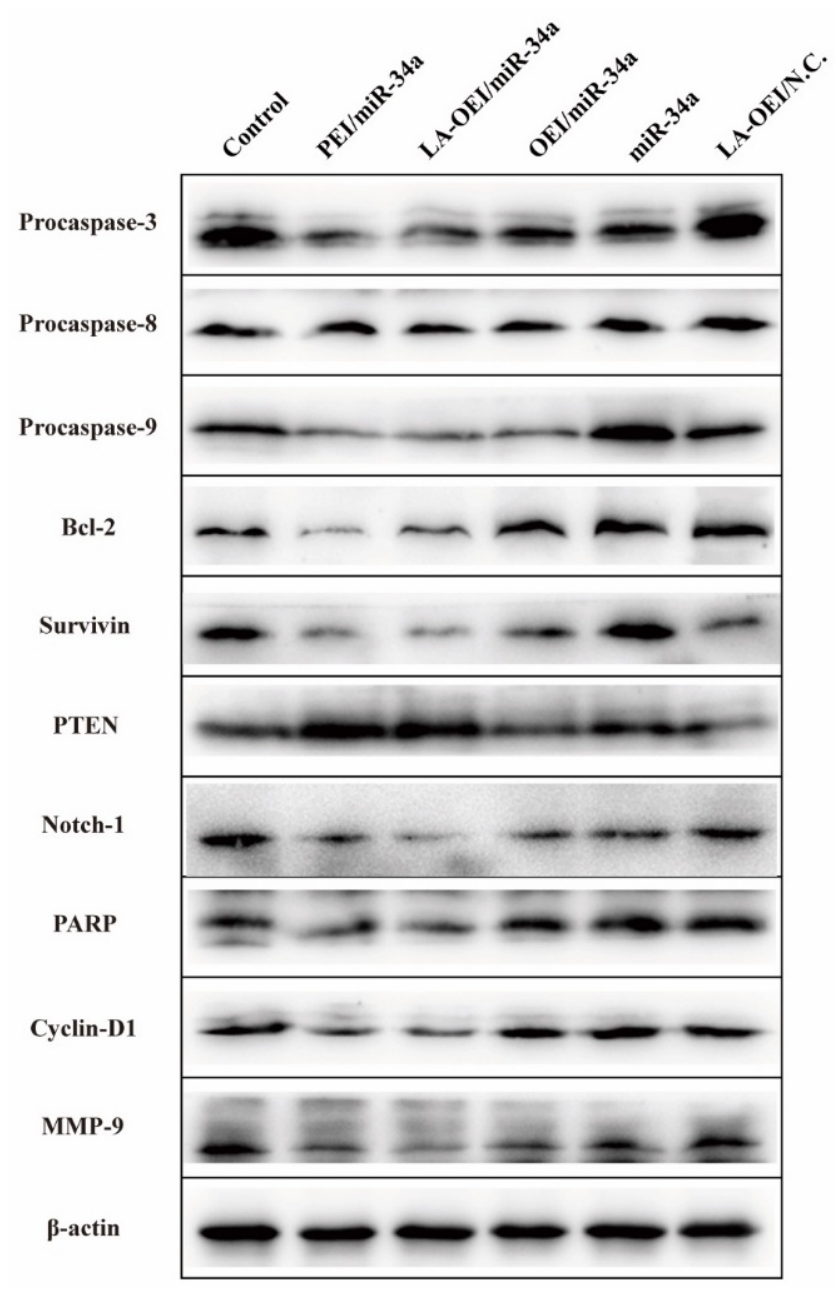
Figure 6. The protein expression level analysis after the miR-34a transfection. The HeLa cells were treated with different nanoparticles and the related proteins were analyzed using Western blotting.